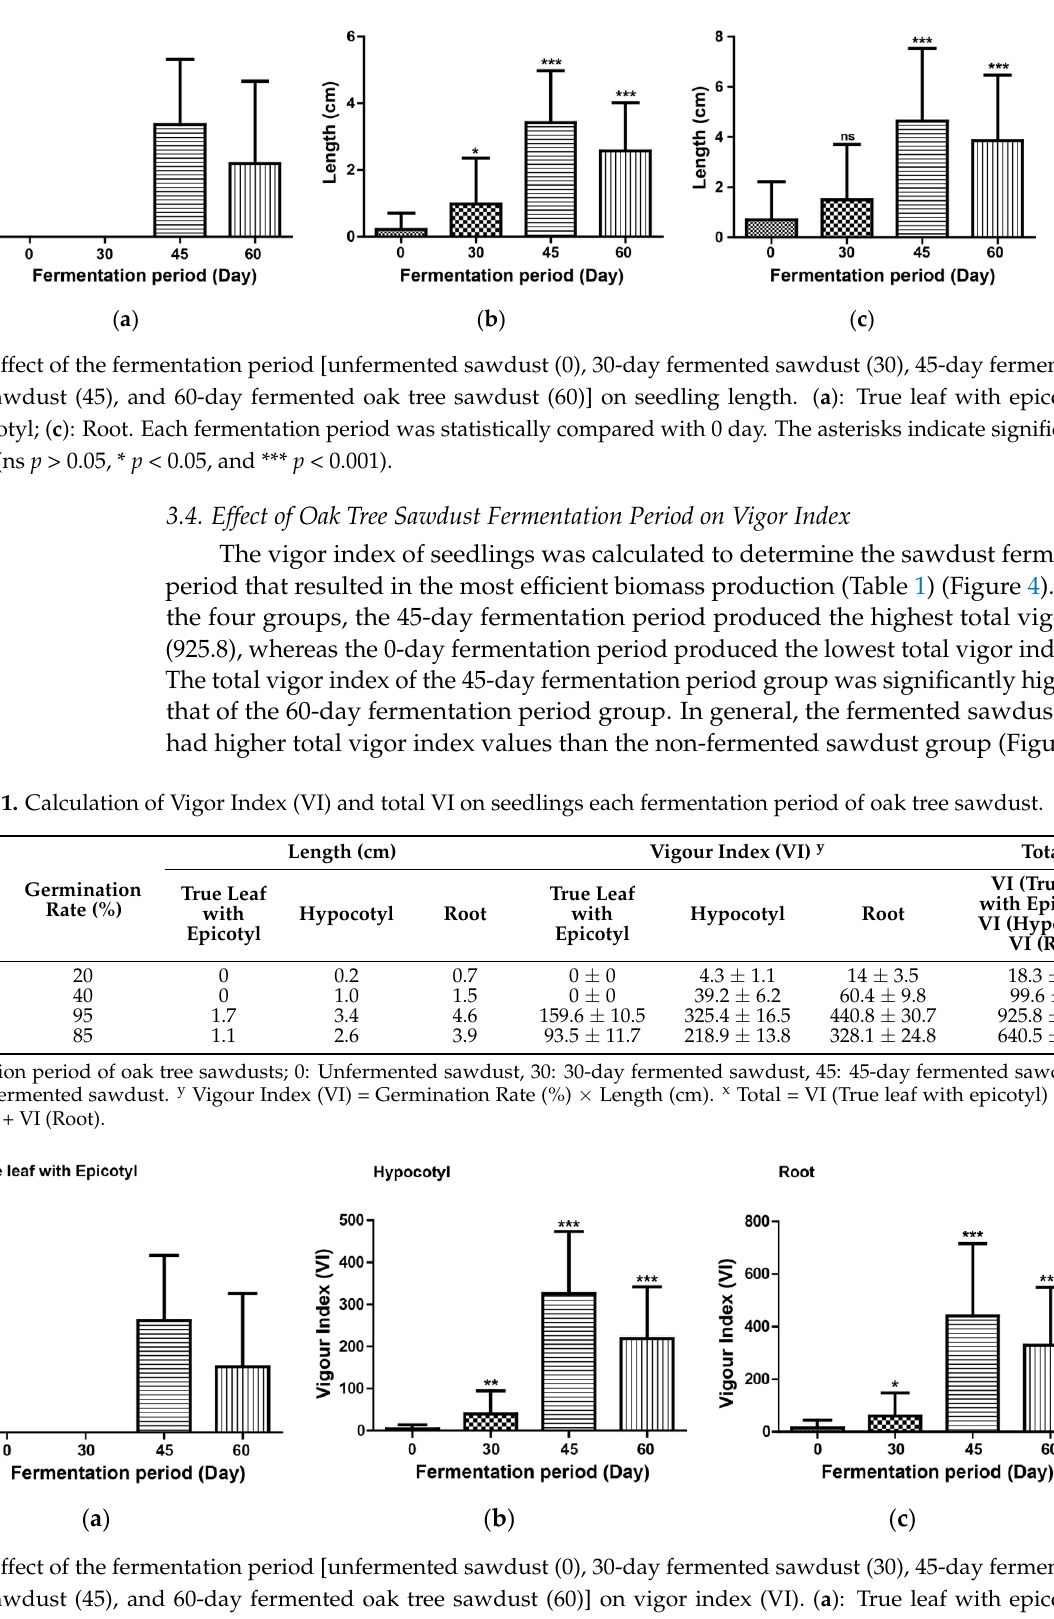
( d ) Figure 5. Effect of the fermentation period on the phenotype of the germinated seedling. ( a ): (unfermented oak tree saw- dust); ( b ): (30-day fermented oak tree sawdust); ( c ): (45-day fermented oak tree sawdust); ( d ): (60-day fermented oak tree sawdust). Scale bar = 2 cm. 3.5. Effect of Oak Tree Sawdust Fermentation Period on Seedling Morphology Among the four fermentation period groups, the seedlings in unfermented sawdust had the shortest hypocotyl and root (Figure 5a). The true leaf and epicotyl were not ob- served in unfermented sawdust (Figure 5a). The epicotyl and the root of seedlings in the 30 day fermentation period group were slightly longer than seedlings in unfermented sawdust (Figure 5a,b). The true leaf and epicotyl were observed in seedlings in the 45- and 60-day fermentation period groups (Figure 5c,d). The hypocotyls of seedlings in the 45-